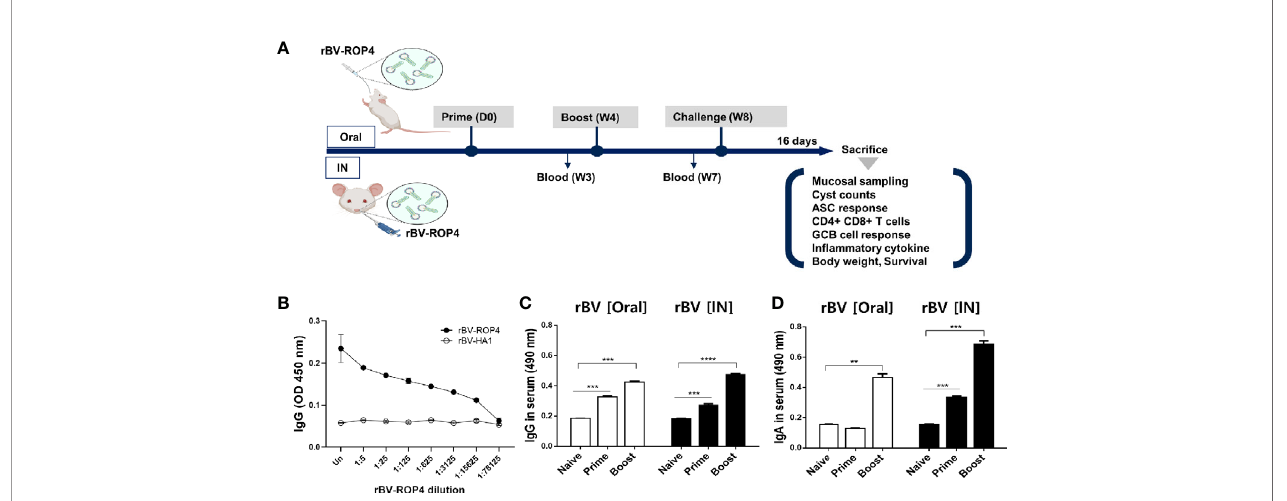
FIGURE 1 | Immunization schematicand T. gondii ROP4-speci fi c antibodyresponses. BALB/cmice were immunized with the ROP4-rBVs vaccine through the oraland intranasalroutes with blood collection atregular intervalsas scheduled (A) . Polyclonal T. gondii antibody collected frommicewas used to assess ROP4-speci fi city via ELISA (B) . Sera were collected3 weeksafter each immunization and T. gondii ME49 antigen-speci fi c IgG (C) andIgA (D) antibody responses were determined by ELISA. Data are presentedas mean ± SD and asterisks indicate statisticaldifferences between groups (** P < 0.01, *** P < 0.001, **** P < 0.0001).Images were created with